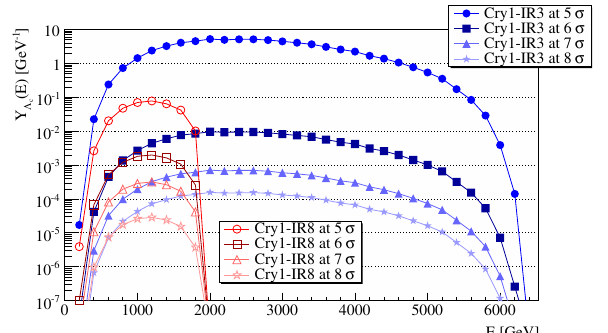
Fig. 13 Expected yield of (cid:2) c emerging from Cry 2 that acquired the desired precession in 10 h LHC fill as defined in Eq.